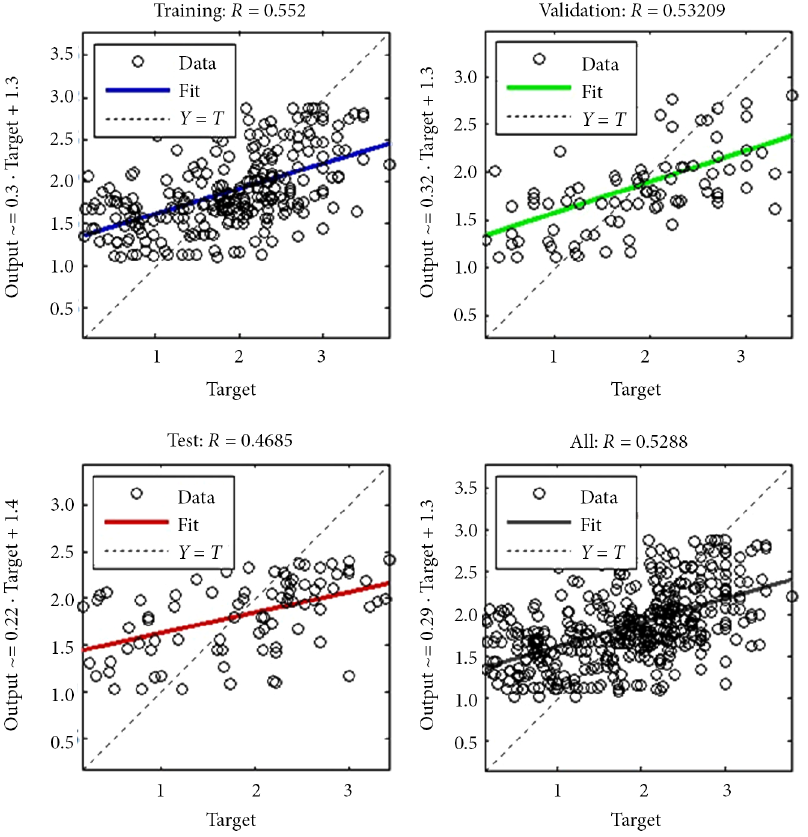
Fig. 7. Cross validate graph by